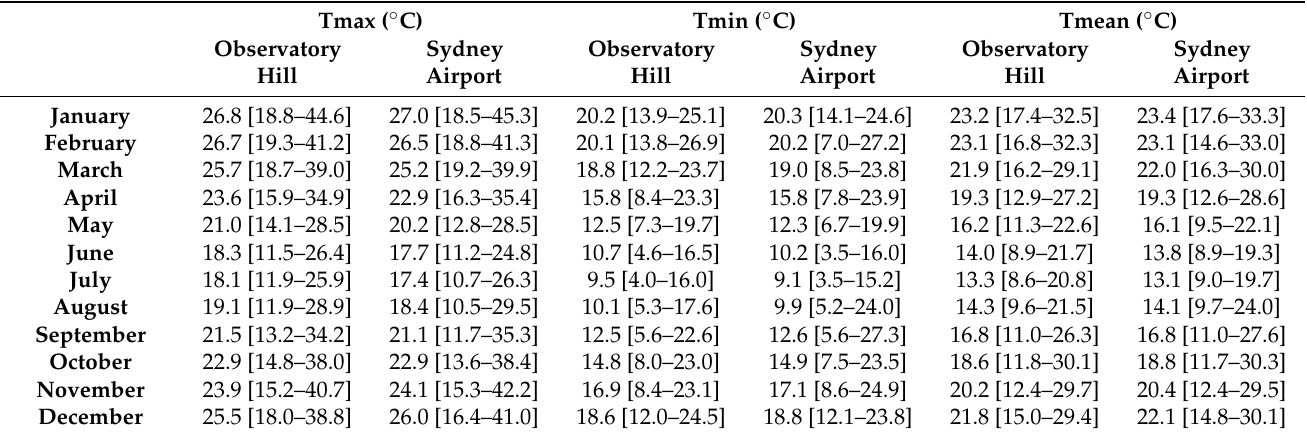
Table 1. Average monthly maximum (T max ), minimum (T min ) and mean (T mean ) air temperatures [absolute minimum– maximum monthly temperatures] for years 2000–2019 for the Observatory Hill and Sydney airport stations.